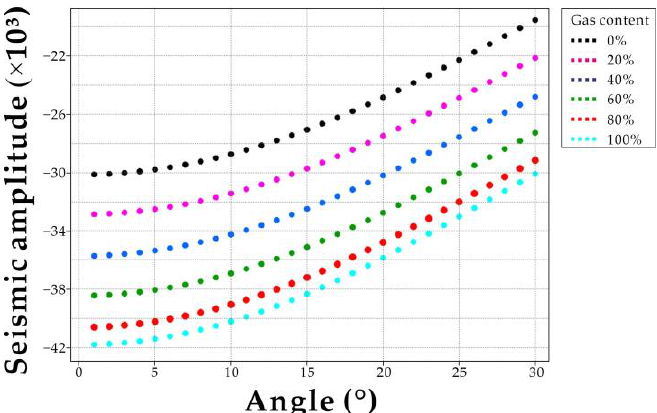
Figure 8. The amplitude of coal roof with different gas content in the forward model varies with the offset (intercept is all negative and decreases with the increase in gas content (absolute value in- creases), and the degree of decrease becomes smaller. The amplitude increases with the increase in incident angle (offset) (the total value decreases). Gradients are positive and do not change signifi- cantly with gas content.